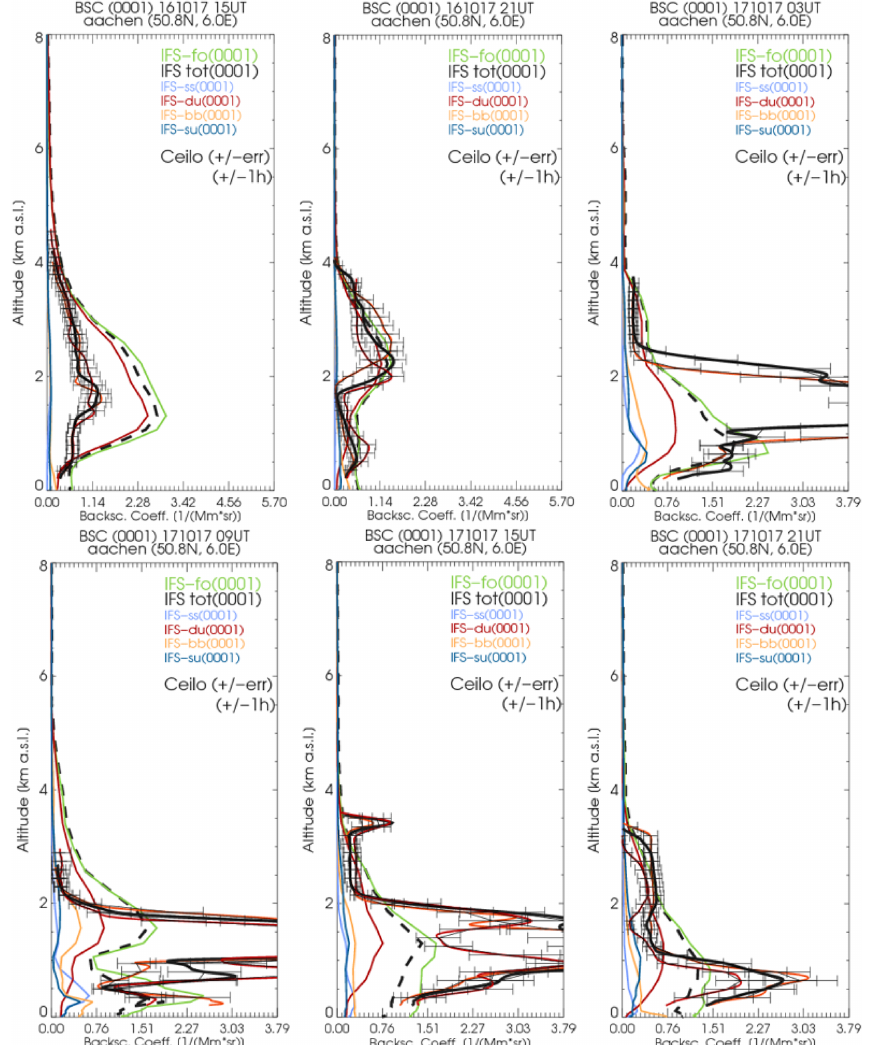
Figure B2. Profiles of β ∗ (z) from the ceilometer near Aachen on 16 (15:00, 21:00UTC) and 17 (03:00, 09:00, 15:00, 21:00UTC) Octo- ber 2017 from IFS-AER and ceilometer. The dashed black line is calculated with the DWD forward operator (FO); the green line is calculated using the ECMWF FO, retrieved as “attenuated backscatter from ground” from the MARS archive. Onset of cloud formation occurs in the SD air mass on early 17 October. Colored profiles show the contributions of individual aerosol